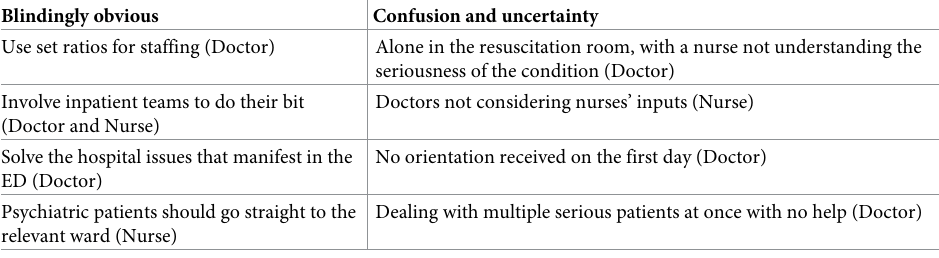
The three clusters identified in Fig 1 are: Top left: Feeling swamped with information, yet the consequence of the decision is obvious Top right: Feeling swamped with information, yet confused about the consequence Bottom left: Enough information and obvious consequence of the decision